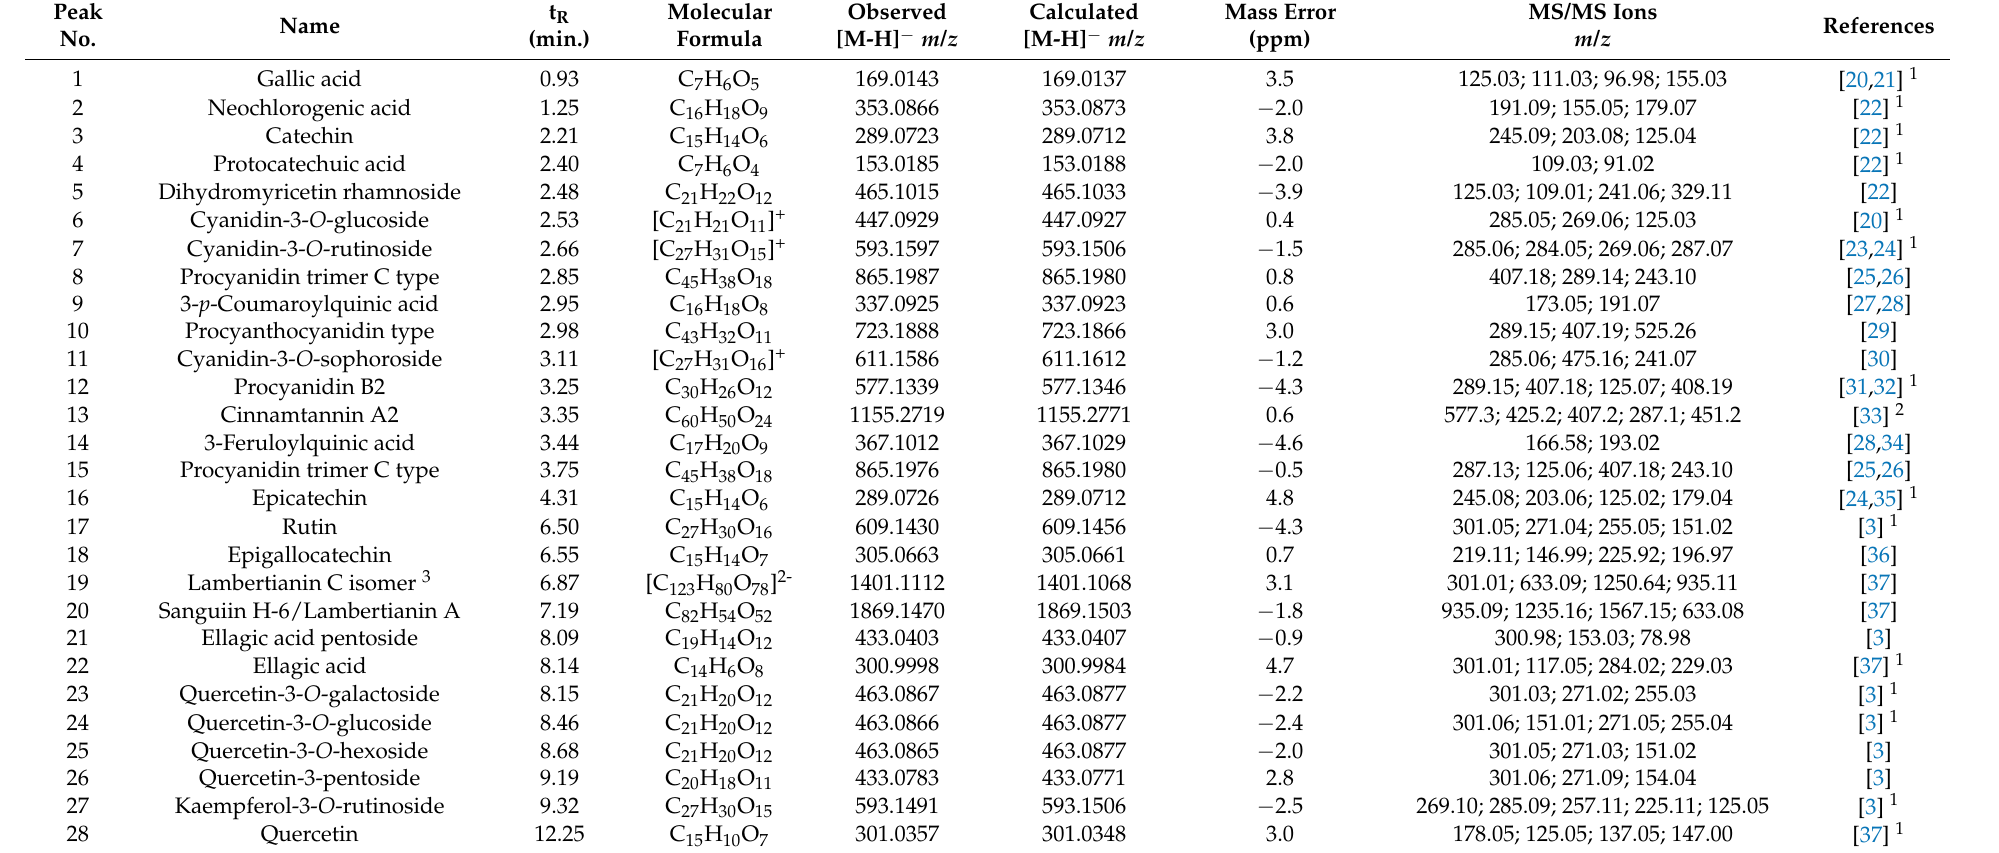
Table 2. Characterization of phenolic compounds in lyophilized blackberry extract prior flash fractionation by LC-QTOF mass